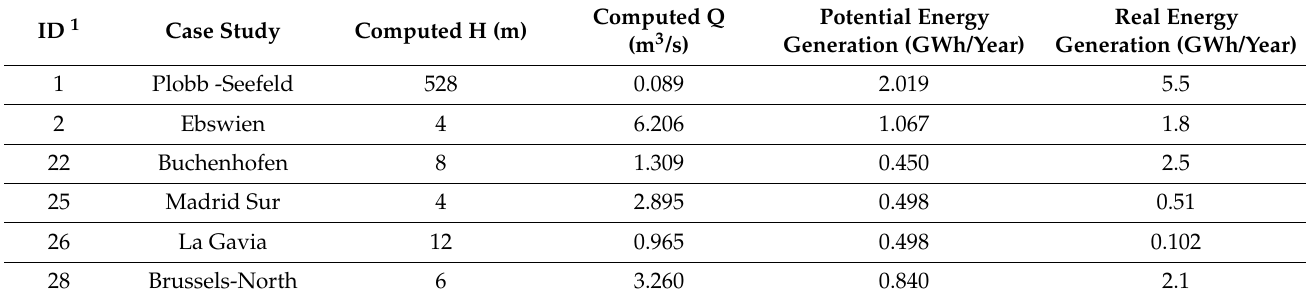
Table 6. Comparison of data from literature review for the hydropower installed and the computed values. ID